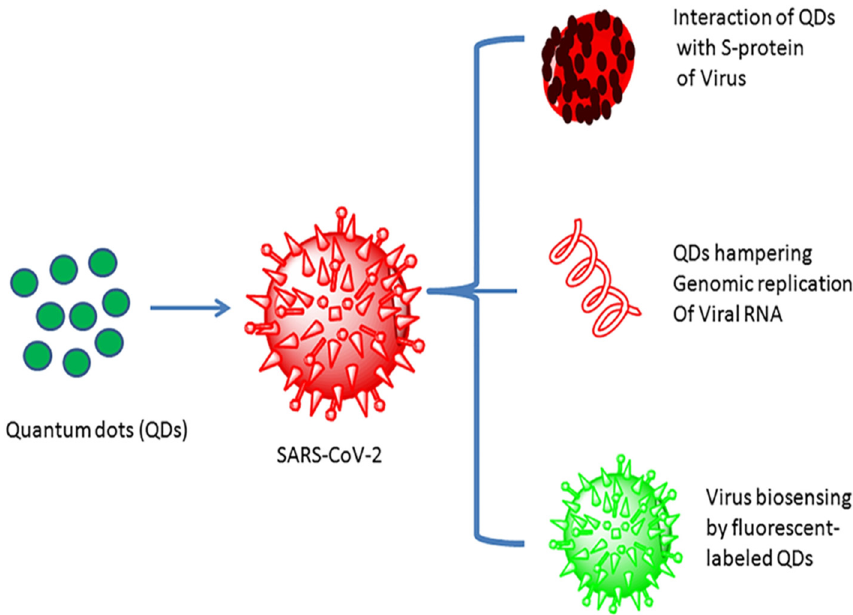
Figure 8. Quantum dot interaction with the SARS-CoV-2 virus and their utility (reproduced with permission from Manivannan, S. and Ponnuchamy, K., 2020, Appl. Organomet. Chem., 34 [127]).